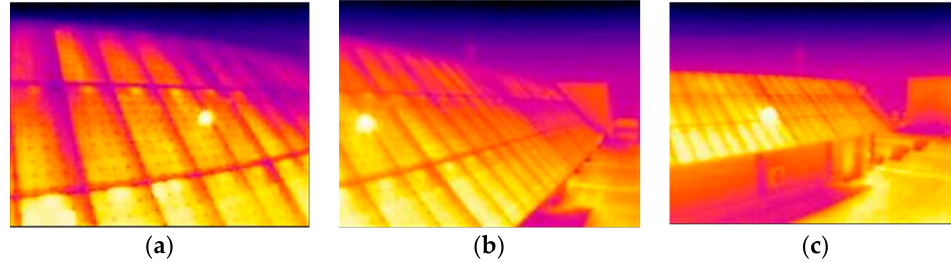
Figure 20. Three thermographs affected by the reflection of the Sun. ( a ) August 5 11:29, dist.: 3 m, angle: 20°; ( b ) August 5 11:37, dist.: 3 m, angle: 45°; and ( c ) August 5 11:39, dist.: 7 m, angle: 45°.